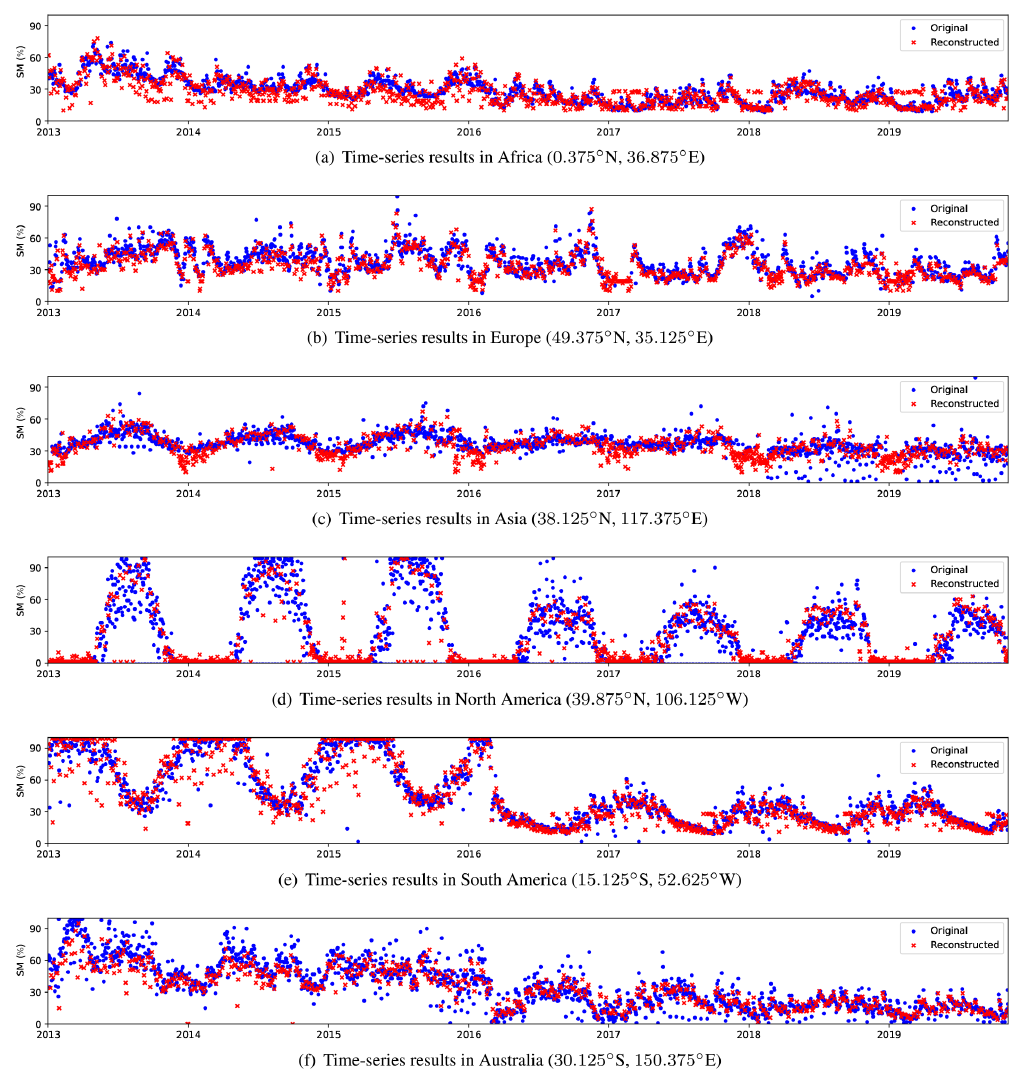
Figure 8. Original and reconstructed time-series results in selected regions.